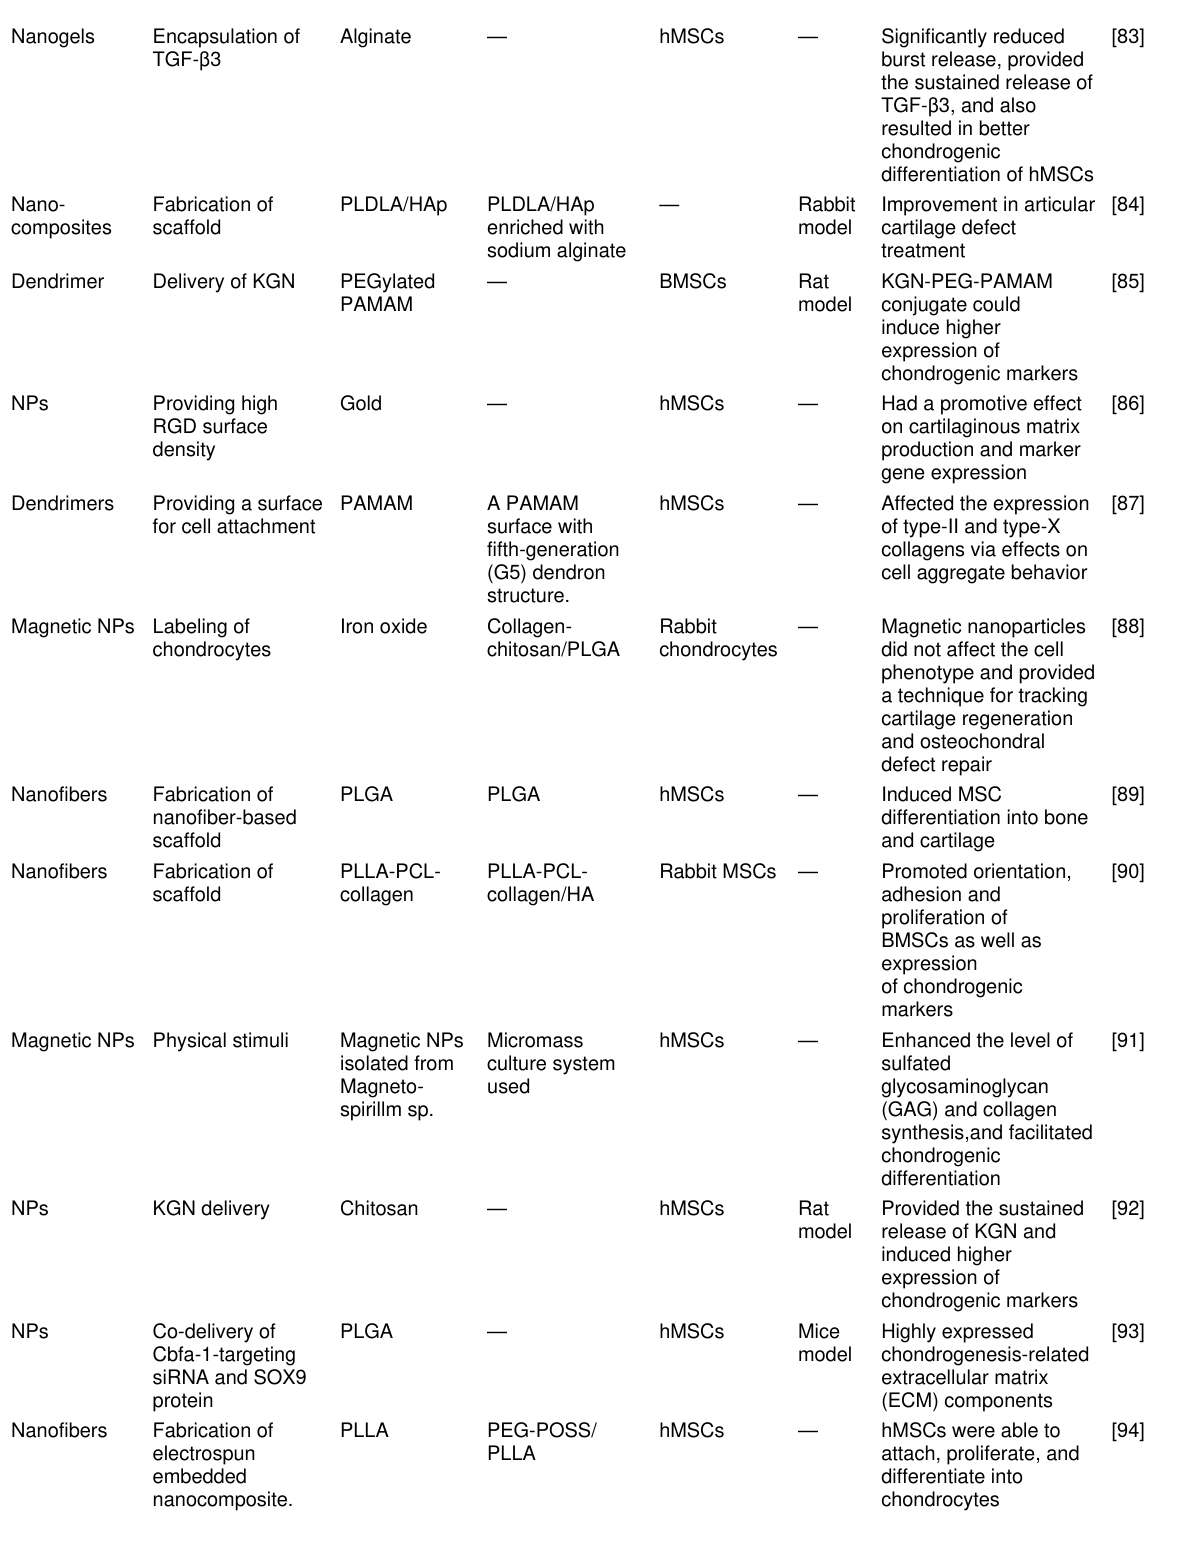
Table 1: Summary of the recent studies on microscale/nanoscale materials used for the fabrication of cartilage tissue engineering (TE) structures. (continued)